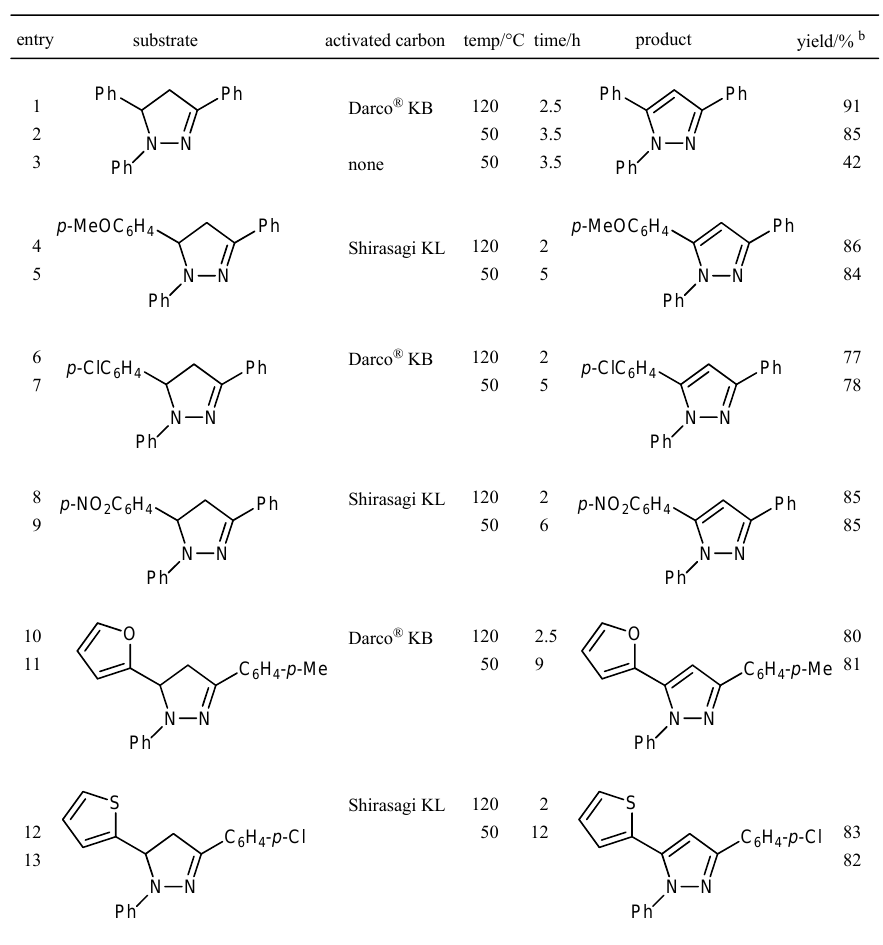
Table 3. Oxidative aromatization of 1,3,5-trisubstituted pyrazolines with molecular oxygen promoted by activated carbon.